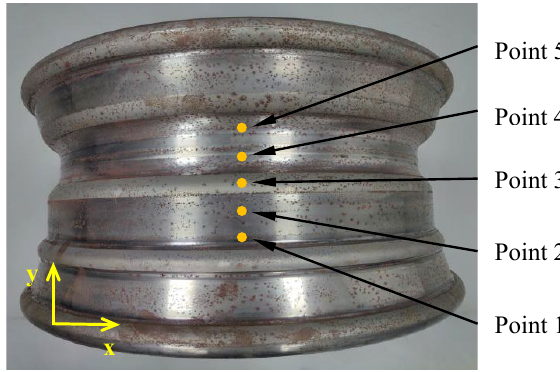
Figure 7. Residual stress detection. Table 1. Residual stress testing results.